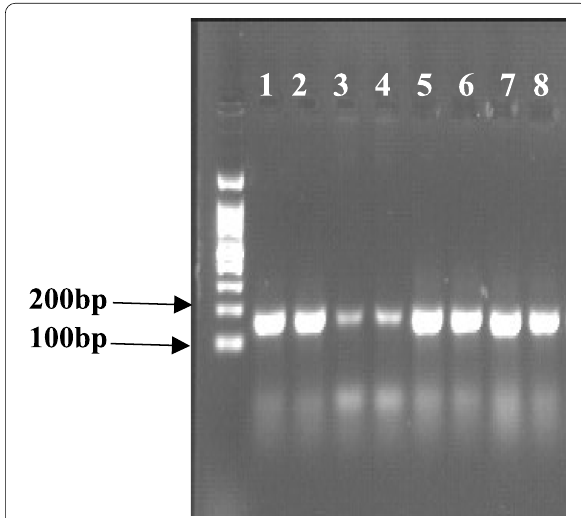
Fig. 11 Real-time-PCR (RT-PCR) of PEPC gene under normal conditions and drought stress. Bands1–2 and 5–6 show RT-PCR for the normal conditions, while bands 3–4 and 7–8 show RT-PCR under drought